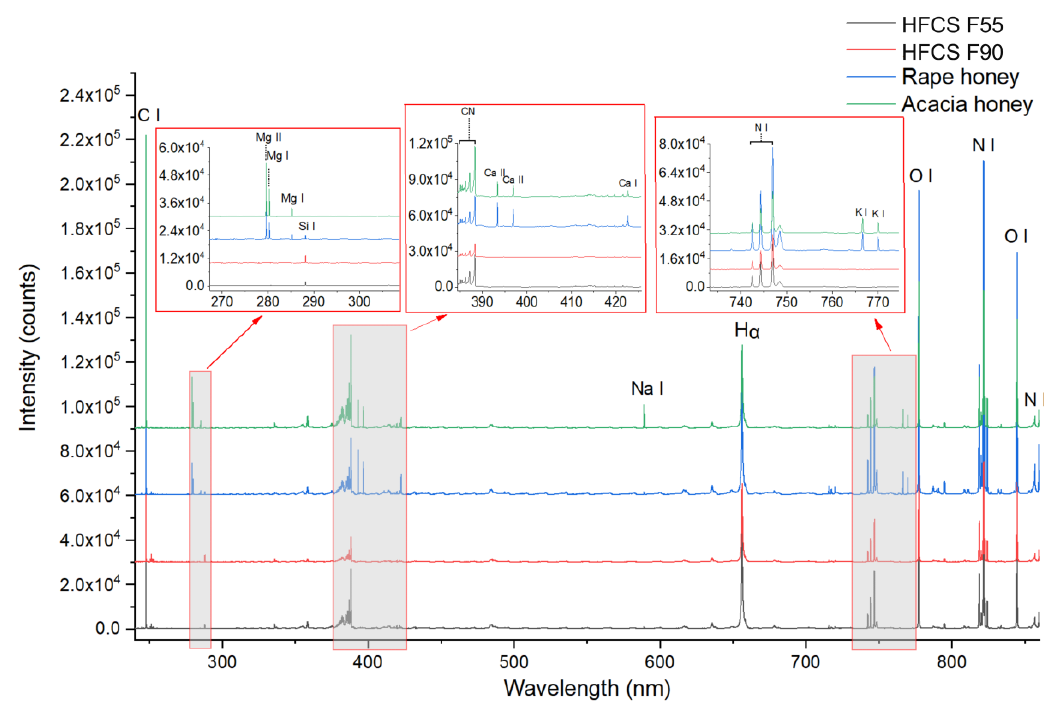
Figure 1. Average laser-induced breakdown spectroscopy (LIBS) spectrum of honey (acacia honey and rape honey) and high fructose corn syrup (HFCS 55 and HFCS 90).